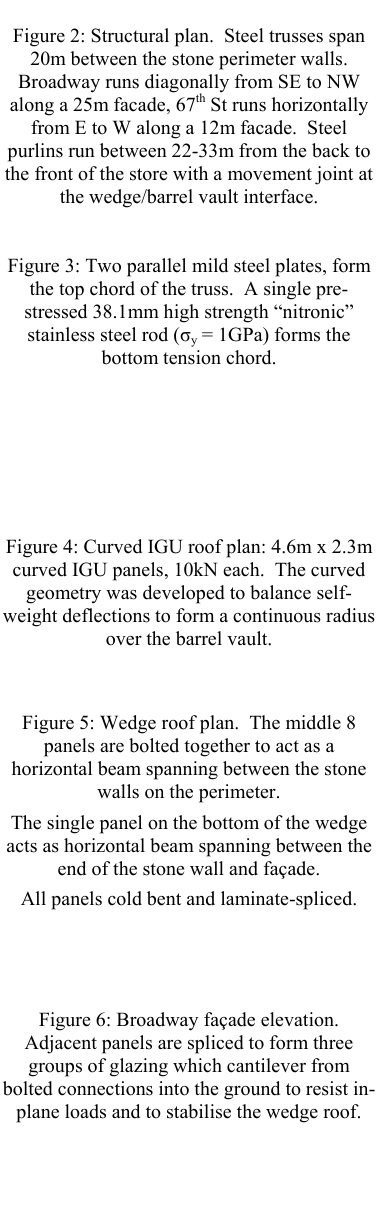
Figure 6: Broadway façade elevation. Adjacent panels are spliced to form three groups of glazing which cantilever from bolted connections into the ground to resist in- plane loads and to stabilise the wedge roof.